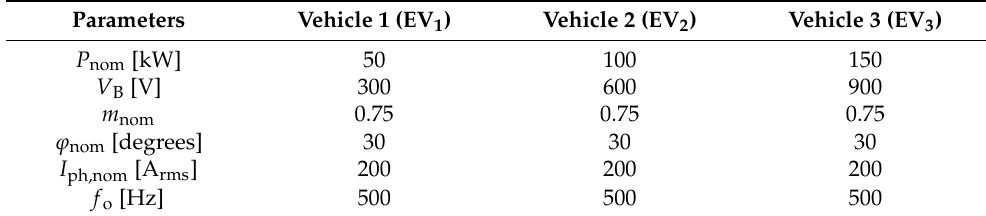
Table 1. Vehicle design